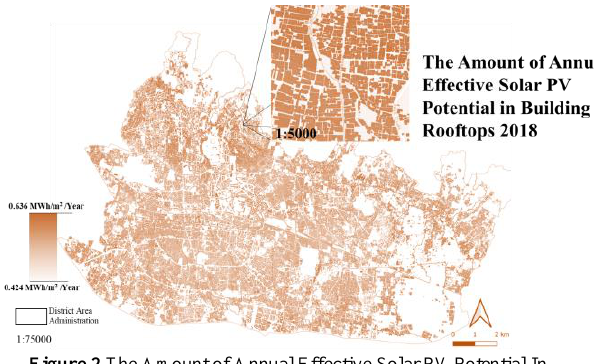
Figure 2 The Amount of Annual Effective Solar PV Potential In Building Rooftops In seeing the suitability of the development of a smart energy city, the most suitable areas are located in the suburban area, as shown in Figure 3 . This can be a reference if the government wants high-yield energy, then the selection of suburban areas can be an option.